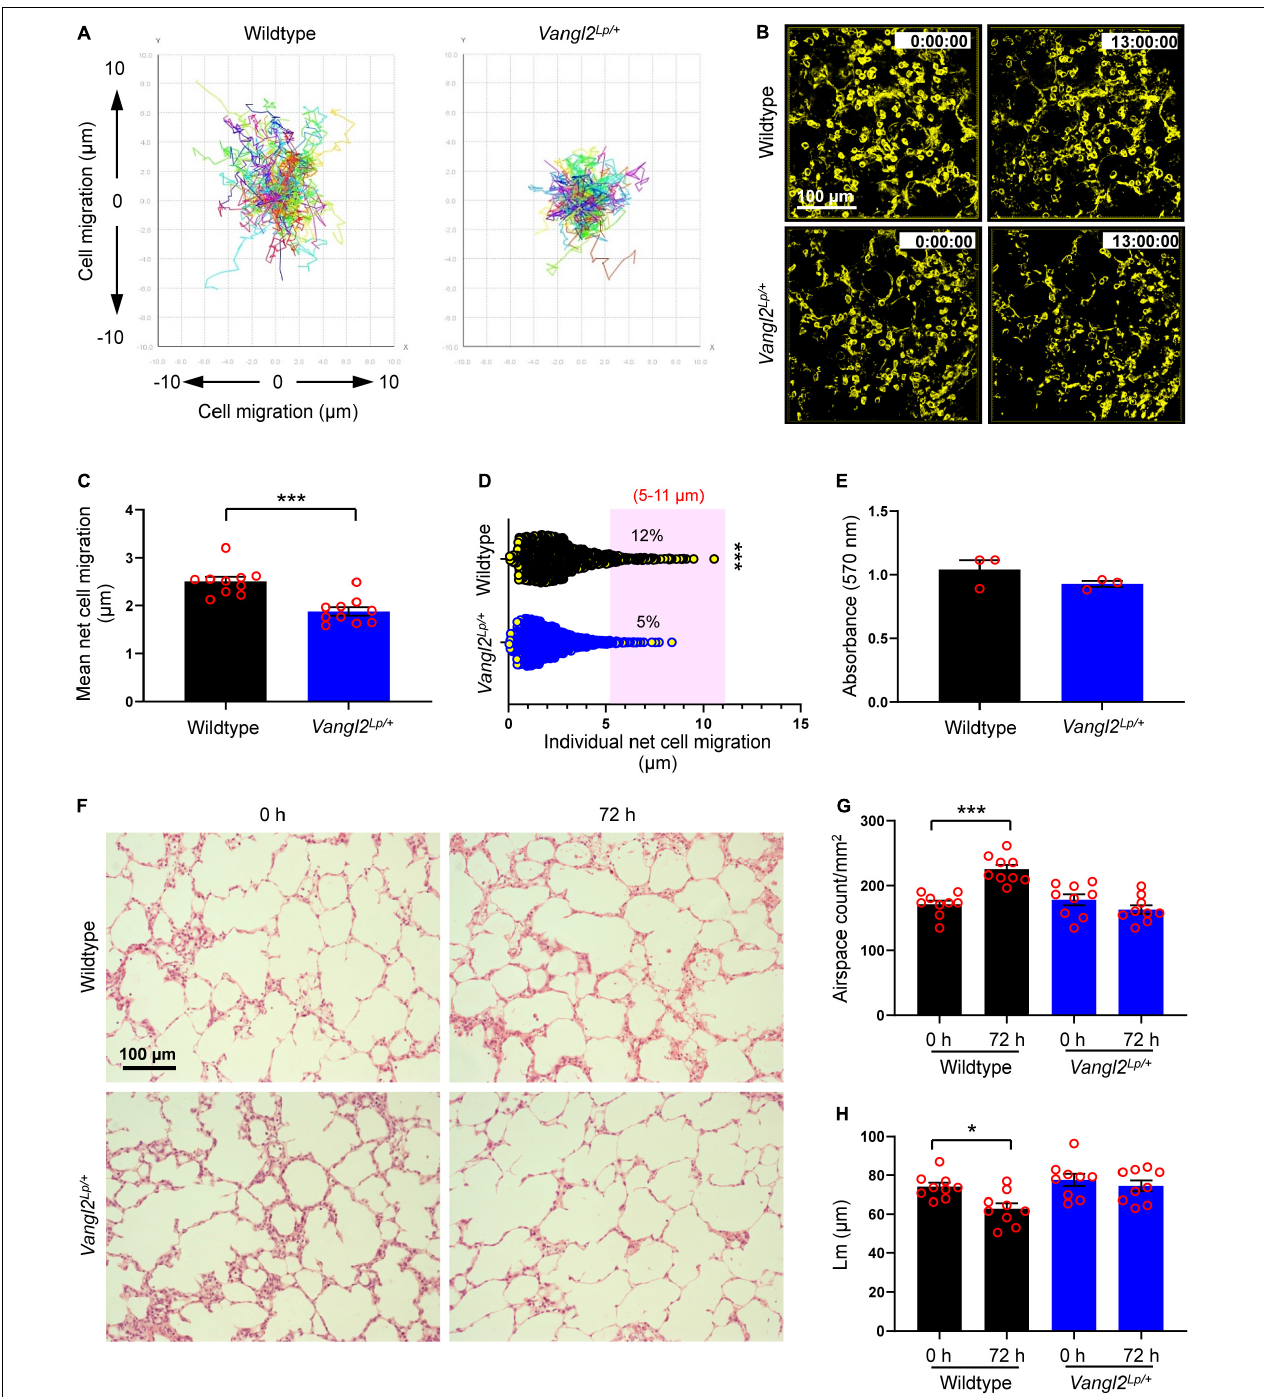
FIGURE 1 | Alveolar epithelial cell migration is disrupted in Vangl2 Lp / + mice during ex vivo alveologenesis. (A) Traces of individual cell tracking over 13 h in a single field from wildtype and Vangl2 Lp / + P3 mouse PCLS. (B) Deconvolved widefield 3D z-stack images extracted from 13 h time-lapse videos ( Supplementary Videos 1, 2 ) of wildtype (top panels) and Vangl2 Lp / + (bottom panels) P3 PCLS labeled with EpCAM-FITC. (C) Mean net epithelial cell migration over 13 h of time-lapse imaging of P3 PCLS. n = 3 independent experiments using three separate mice for each group; at least three fields were quantified from each lung slice from each mouse per group per experiment. Each dot represents mean net epithelial cell migration per field. Mann–Whitney U -test, *** p = 0.0001. (D) Individual net cell migration in wildtype and Vangl2 Lp / + P3 PCLS after 13 h of time-lapse imaging (each dot represents a single cell). A total of 1248 cells in wildtype and 1635 cells in Vangl2 Lp / + P3 PCLS were tracked. Cells fall within the area highlighted in pink were highly motile and migrated between 5 and 11 µ m. n = 3 independent